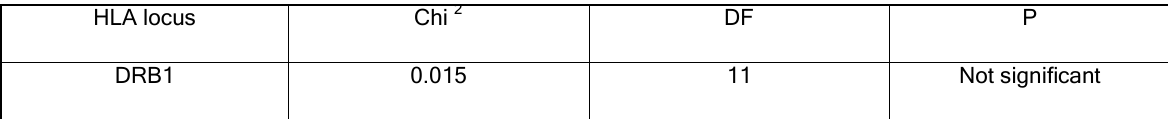
Table-3- Hardy – Weinberg equilibrium in HLA-DRB1 locus of patients with superficial gastritis disease. HLA locus